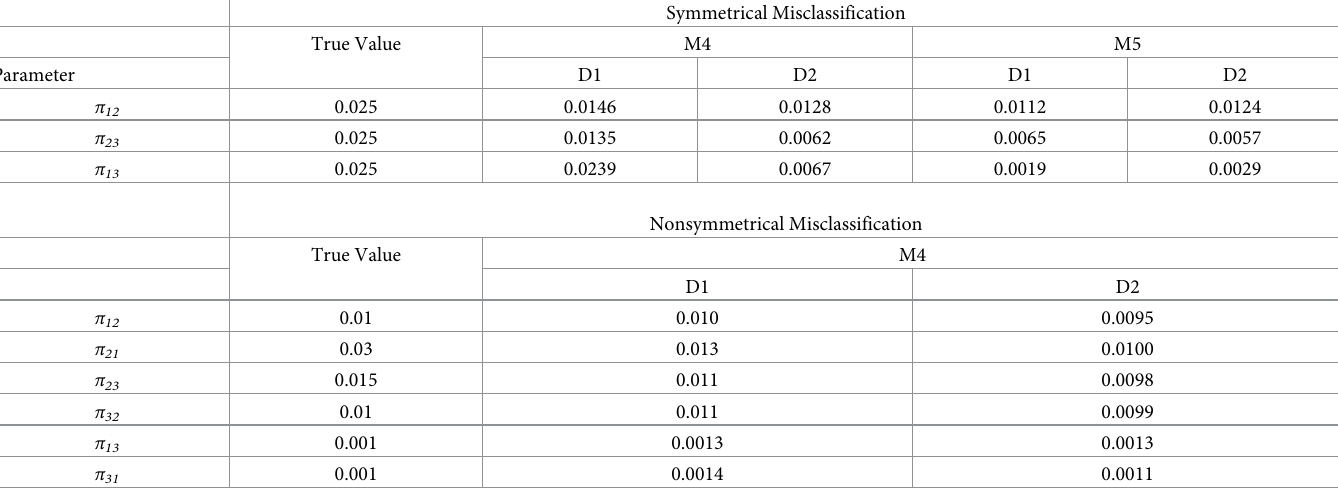
responses were underestimated with posterior means of 0.0146 and 0.0135, respectively, com-